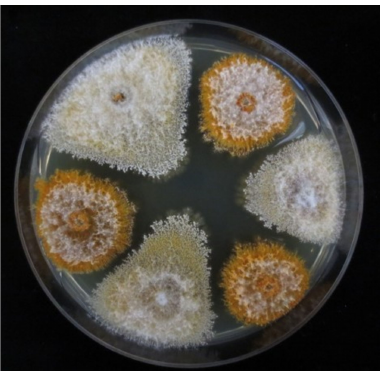
Figure 1. Culture morphology of CHV-1-free (orange) and CHV-1 infected (white) C. parasitica isolates from Georgia on